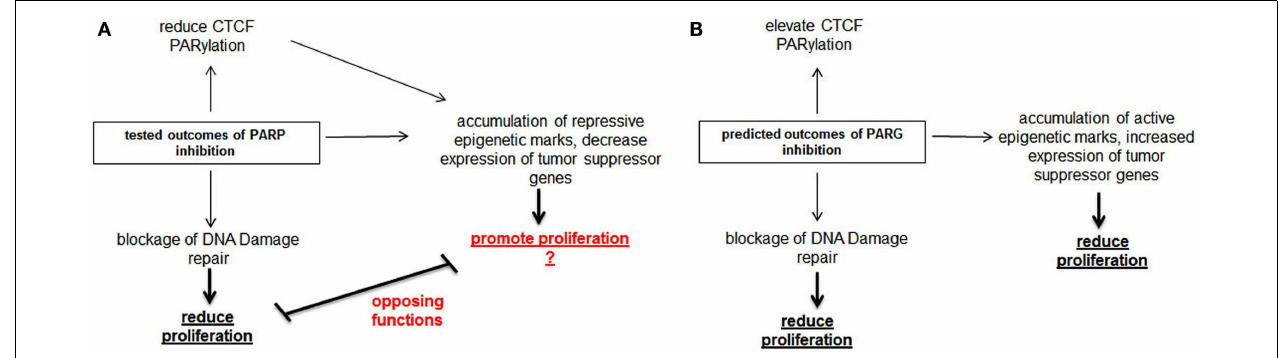
propose that these properties of Parp inhibitors will limit their usefulness as anti-cancer therapeutics. (B) In contrast, we predict Parg inhibitors will stimulate Ctcf PARylation and the transcription of tumor suppressor genes, in addition to blocking the DNA damage repair response.Thus, Parg inhibition may have greater potential as an anti-cancer therapeutic than Parp